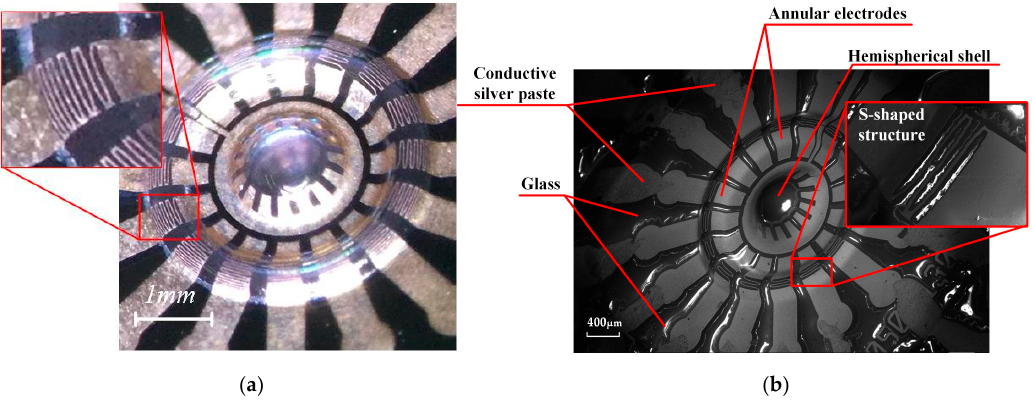
Figure 8. Photographs of optimized annular electrodes and hemispheric shell. Metal traces are not broken. ( a ) is observed by optical microscope; and ( b ) is by SEM.